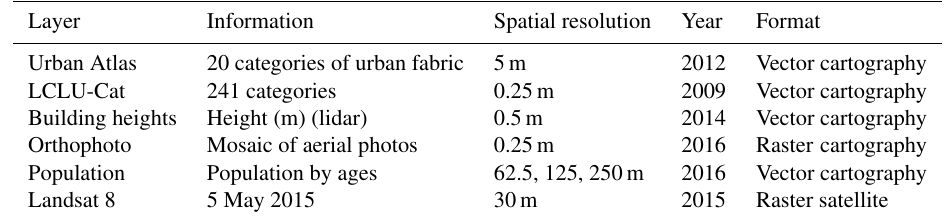
Table 1. Vector and raster cartographic data and satellite images used to map the LCZ LCLU and LCZ WUDAPT